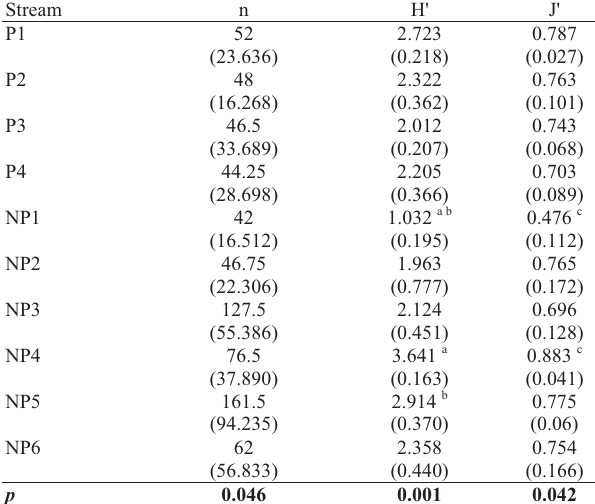
Table 3. Average and standard deviation values (in parenthesis) of abundance (n), Shannon-Wiener diversity Index (H’) and Pielou uniformity (J’) of fish assemblages sampled in stream stretches of the João Leite River. Significant values are indicated in bold (p < 0.05). a, b, c = the same letter indicates significant differences between stretches resulting from post-hoc test (p <